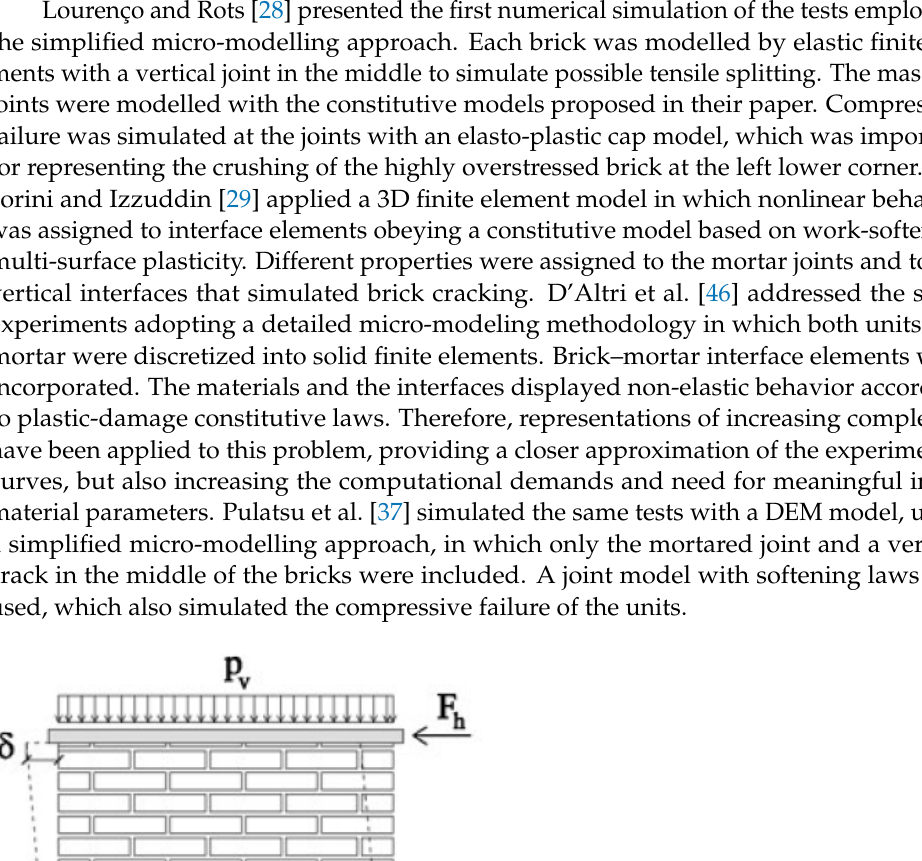
Figure 17. Bonded-block model of shear test of brick panel.